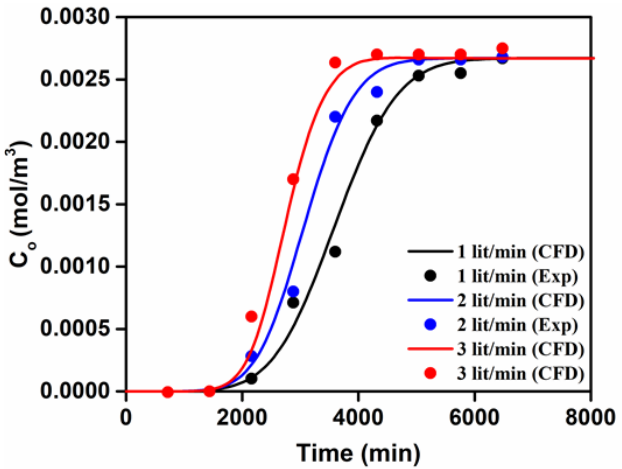
Figure 4. Validation of the CFD model with experimental measurements.